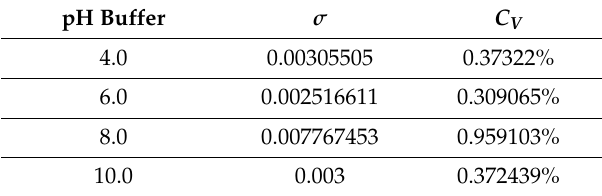
Table 4. Standard deviations and relative standard deviations of measurements of different pH buffers.